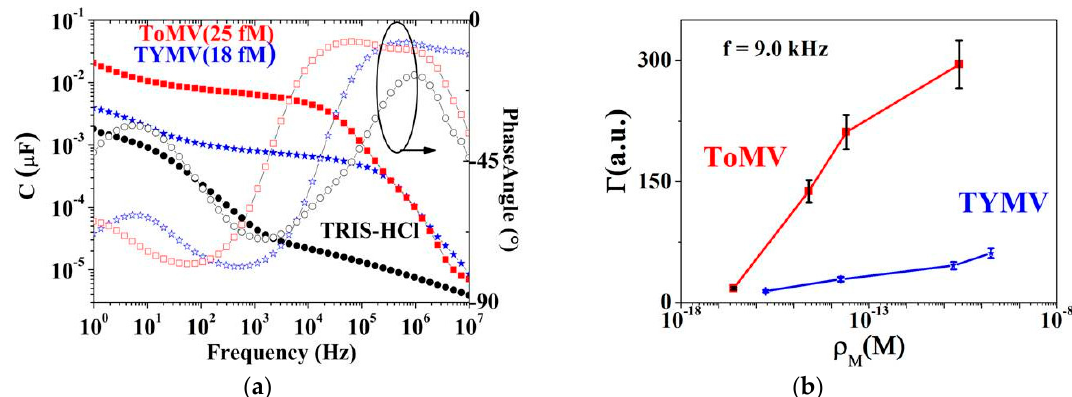
Figure 5. ( a ) Comparison between ToMV and TYMV capacitances (from Equation (2)) and phase angles frequency dispersion for a suspension at similar virus molarity; ( b ) Γ parameters extracted from capacitance values in Figure 5 at 9.0 kHz at the lowest virus molar concentrations corresponding to the plateau region in ( a ). The different capacitance variation vs virus types evidences the feasibility of virus identification by using this method. The full dataset has been reported in Figure S5 (Supplementary Materials).